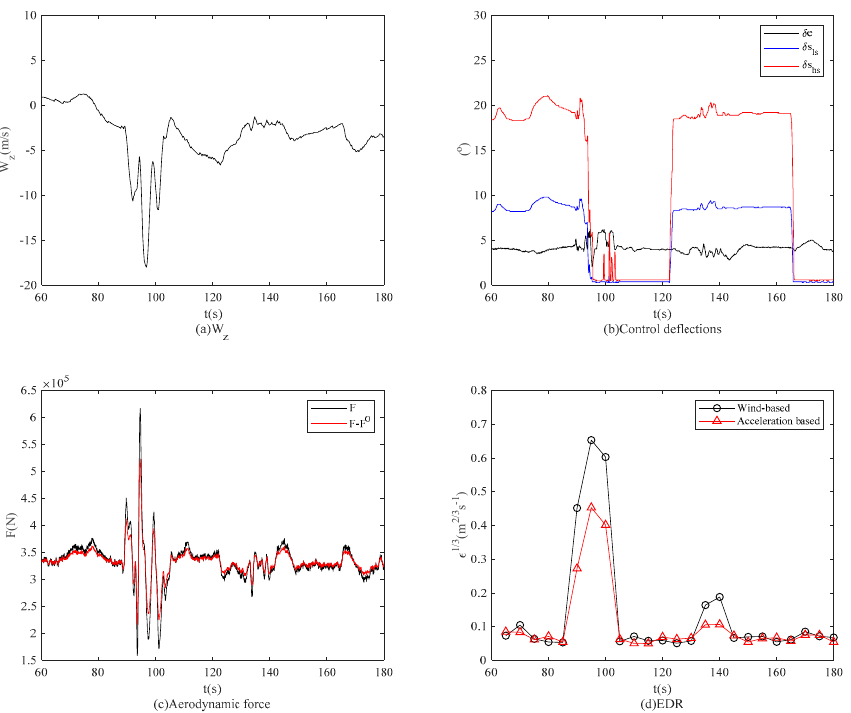
Figure 11. EDR calculation under elevator deflection. ( a ) W z ; ( b ) control deflections; ( c ) aerodynamic force; ( d ) EDR.